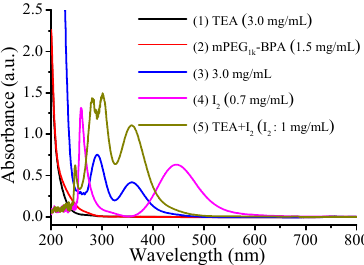
Figure 1. UV-vis absorption spectra of the (1) TEA, (2) mPEG 1k -BPA, (3) polymerization conditions: [BnMA] 0 / [mPEG 1k -BPA] 0 / [NaI] 0 / [TEA] 0 = 20 / 1 / 2 / 0.5, V BnMA = 50 µ L, under irradiation with blue LED light ( λ max = 464 nm, 0.15 mW cm − 2 ) at room temperature (25 °C) after 7 h, (4) I 2 , (5) TEA/I 2 = 4:1. The samples were diluted with methanol before measurement.